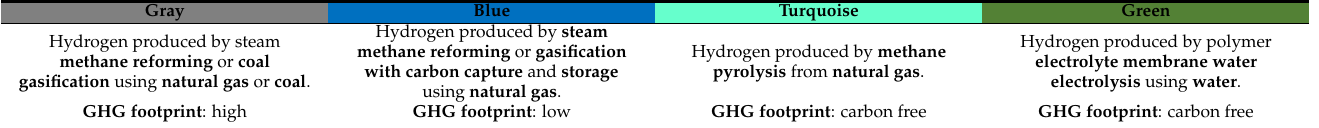
Table 2. The colors of hydrogen. Inspired by [18].